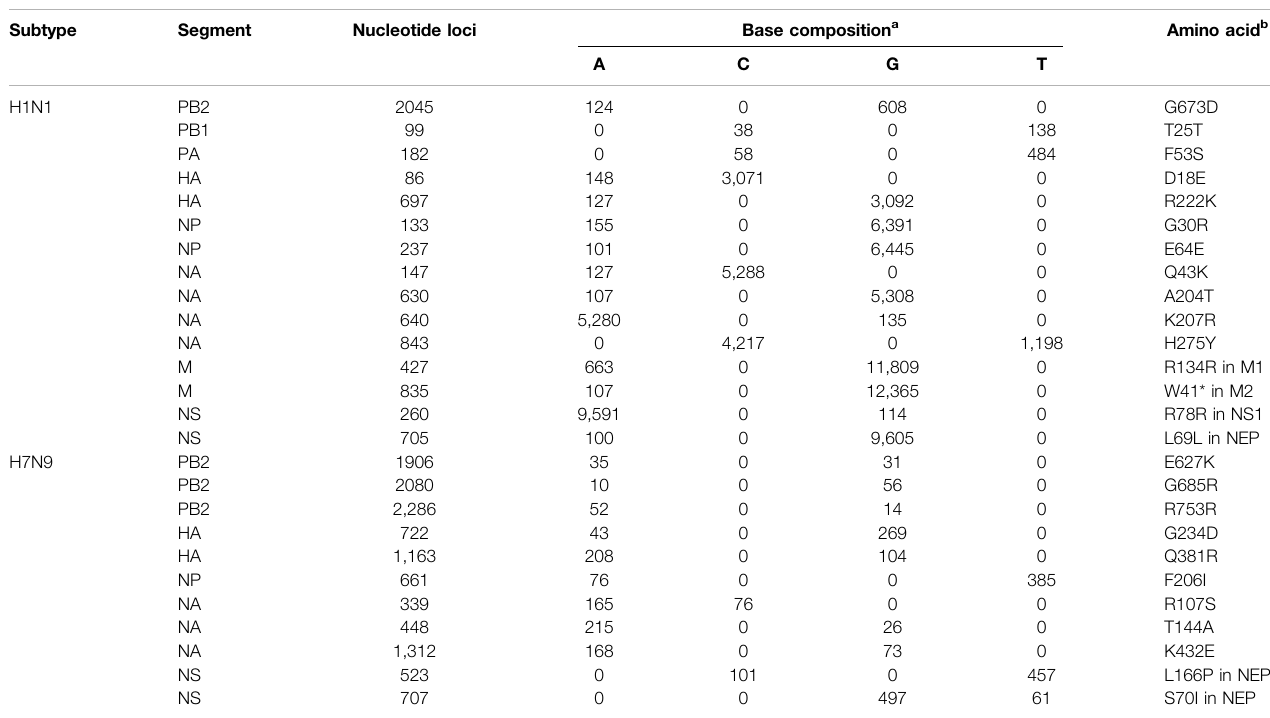
TABLE 3 | The high-diversity nucleotide loci in H1N1 and H7N9 genomes.